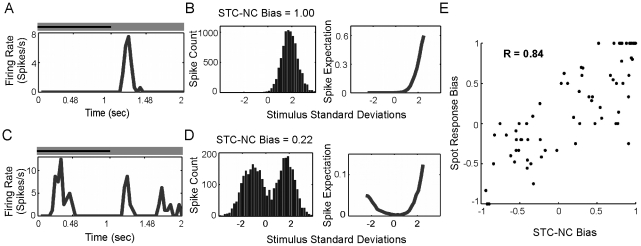
STC-NC Bias correlates well with the Spot Response Bias.(A) ON-center RGC response to spot stimulation. Time-course of stimulus above the histogram. The dark horizontal line indicates a dark spot stimulus. The cell spikes at the offset of the dark spot. (B) ON-center RGC 1D STE projection onto the STC-NC direction and resulting static nonlinearity. (C) ON-OFF RGC response to spot stimulation. The cell spikes following both the onset and offset of the dark spot. This cell also gave a delayed ON response to the offset of the dark spot. (D) ON-OFF RGC 1D STE projection onto the STC-NC direction and the resulting static nonlinearity. (E) Scatter plot of the Spot Response Bias against the STC-NC Bias showed that they were well correlated (R = 0.84).